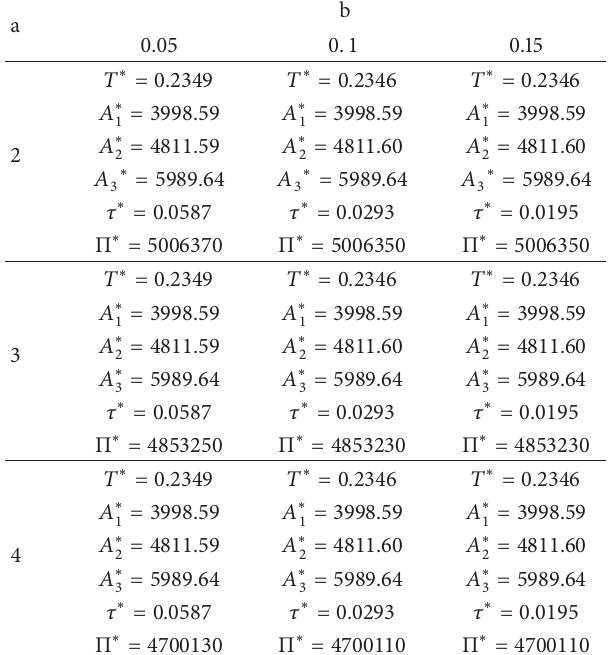
Table 2: Effects of a and b . Table 3: Effects of 𝛼 and 𝛽